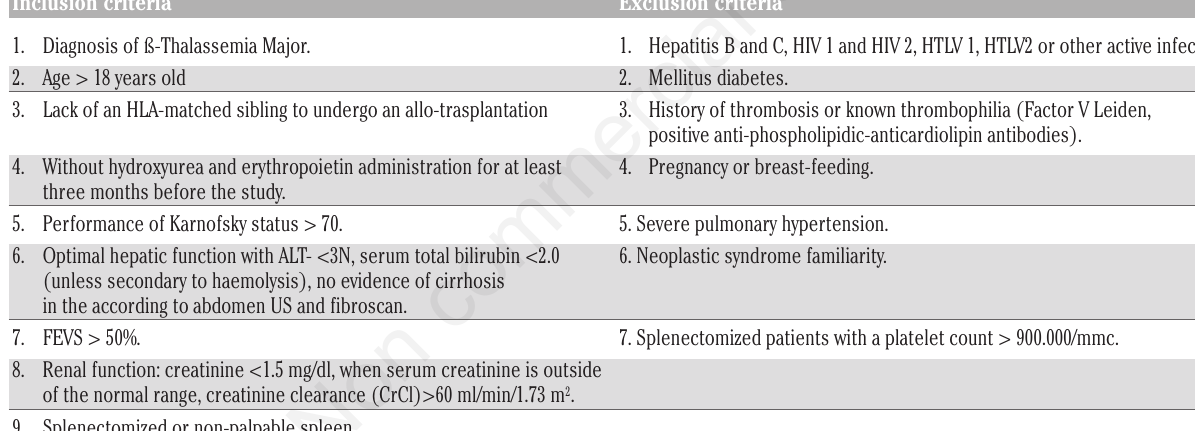
Table 1. Eligibility criteria. Inclusion criteria Exclusion criteria